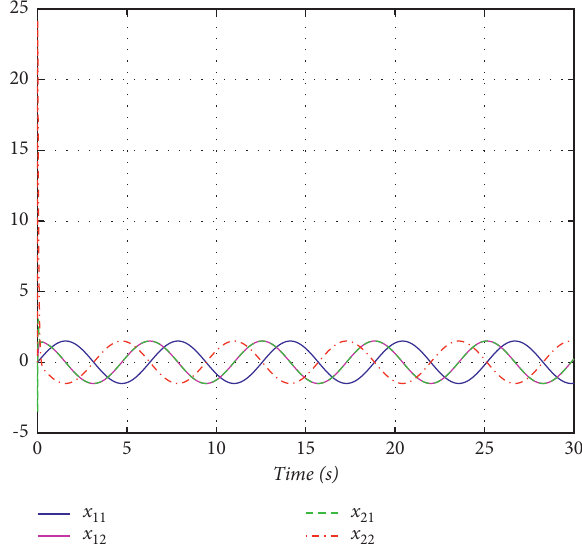
Figure 2: Trajectories of x